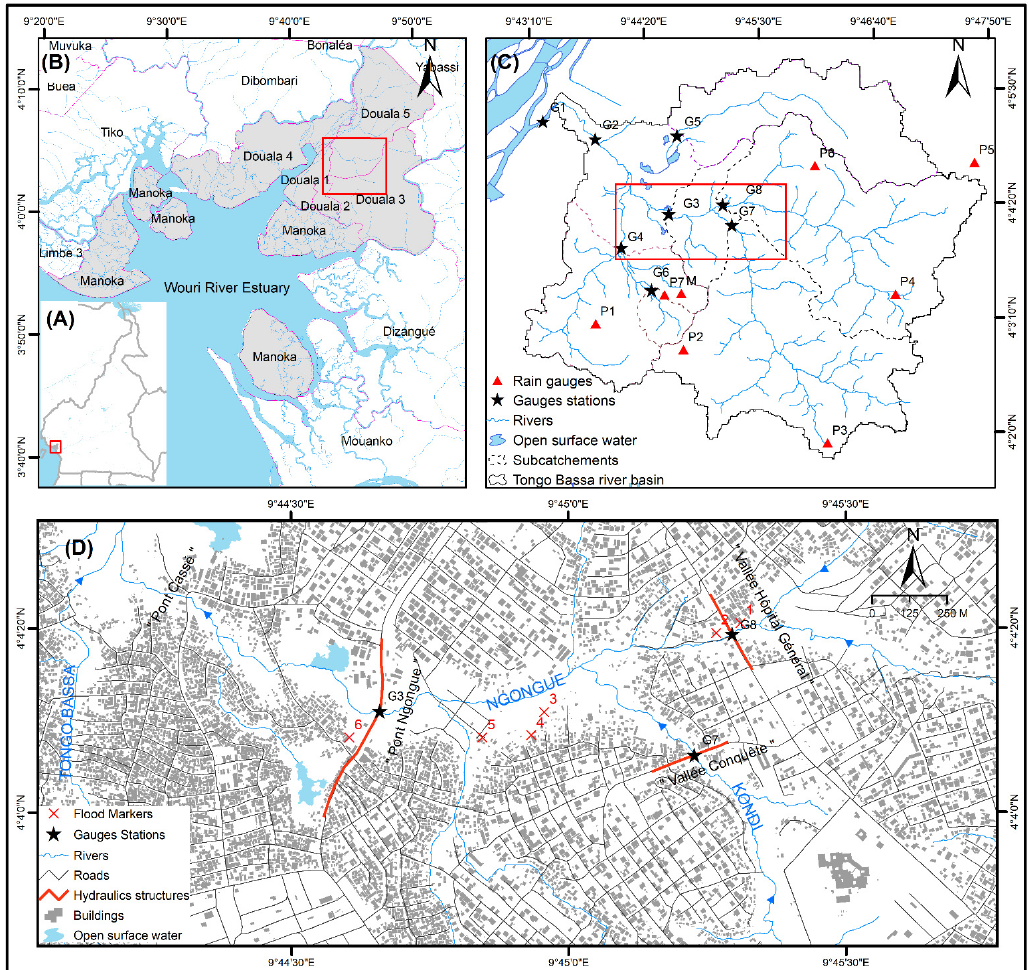
Figure 1. ( A ) Location of the city of Douala on the Cameroon map. ( B ) Wouri river estuary, tributaries, and surrounding districts. Douala subdivisions are presented in grey. ( C ) Location of the Makèpè Missokè district in the Tongo Bassa catchment area and presentation of the environmental observatory. The rain gauge stations (P1 to P7) are labeled by red triangles, the water level gauge stations (G1 to G8) are labeled by circles of the same color as the sub-basin limits drained, and the weather station is labeled as M. ( D ) Presentation of the Makèpè Missokè area, the hydrographic network, built-up areas, roads, hydraulics structures, and flood markers associated with the 21st August 2020 flood event.